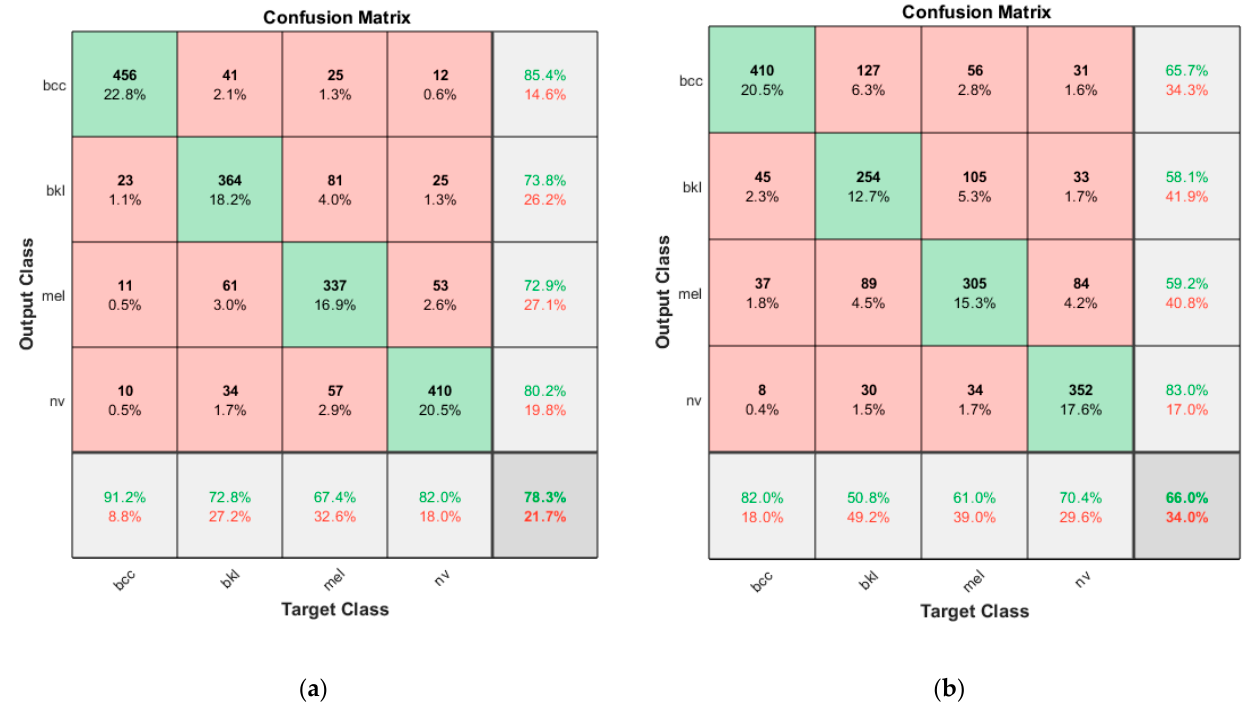
Figure 5. ( a ) Confusion matrix of Model IV using transfer learning; ( b ) confusion matrix of Model II trained from scratch.